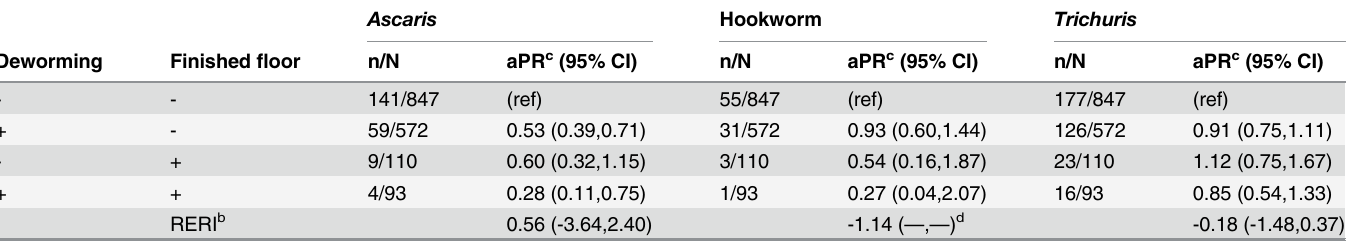
Table 4. Adjusted prevalence ratios for single and combined deworming and household finished floor and relative excess risk due to